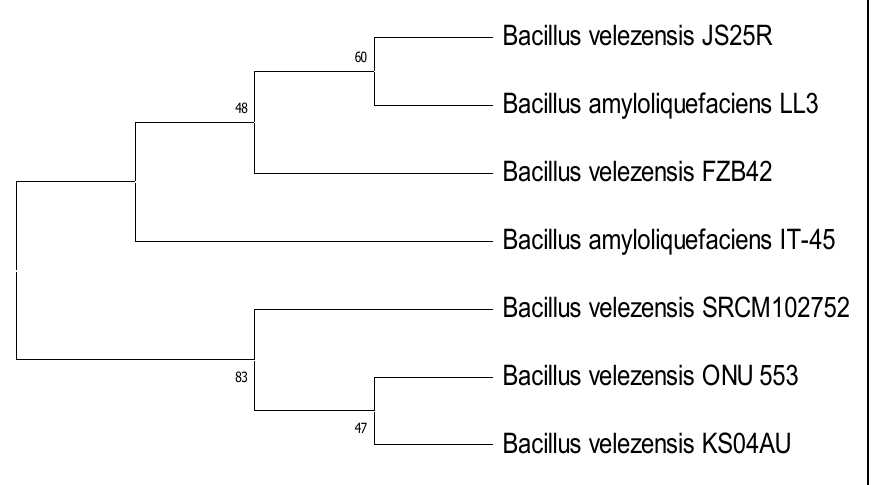
Figure 4. Neighbor-joining phylogenetic tree constructed from 16S rRNA extracted from genomes using the ContEst16S tool. The tree was generated by MEGA 11 using the neighbor-joining method.